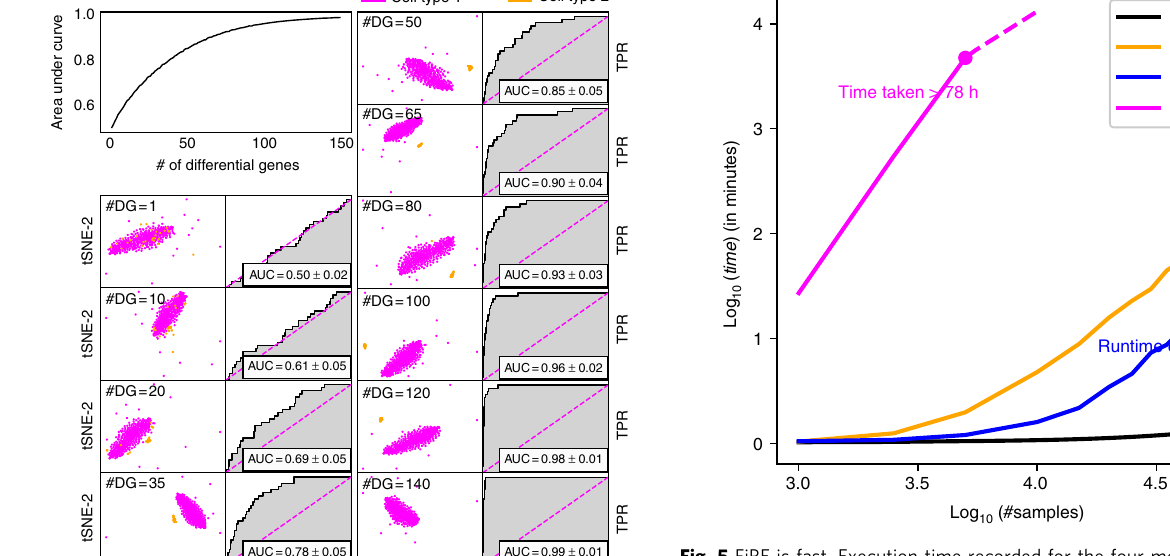
Fig. 5 FiRE is fast. Execution time recorded for the four methods (FiRE, LOF 21 , RaceID 15 and GiniClust 16 ) while varying the number of cells from 1 k to ~68